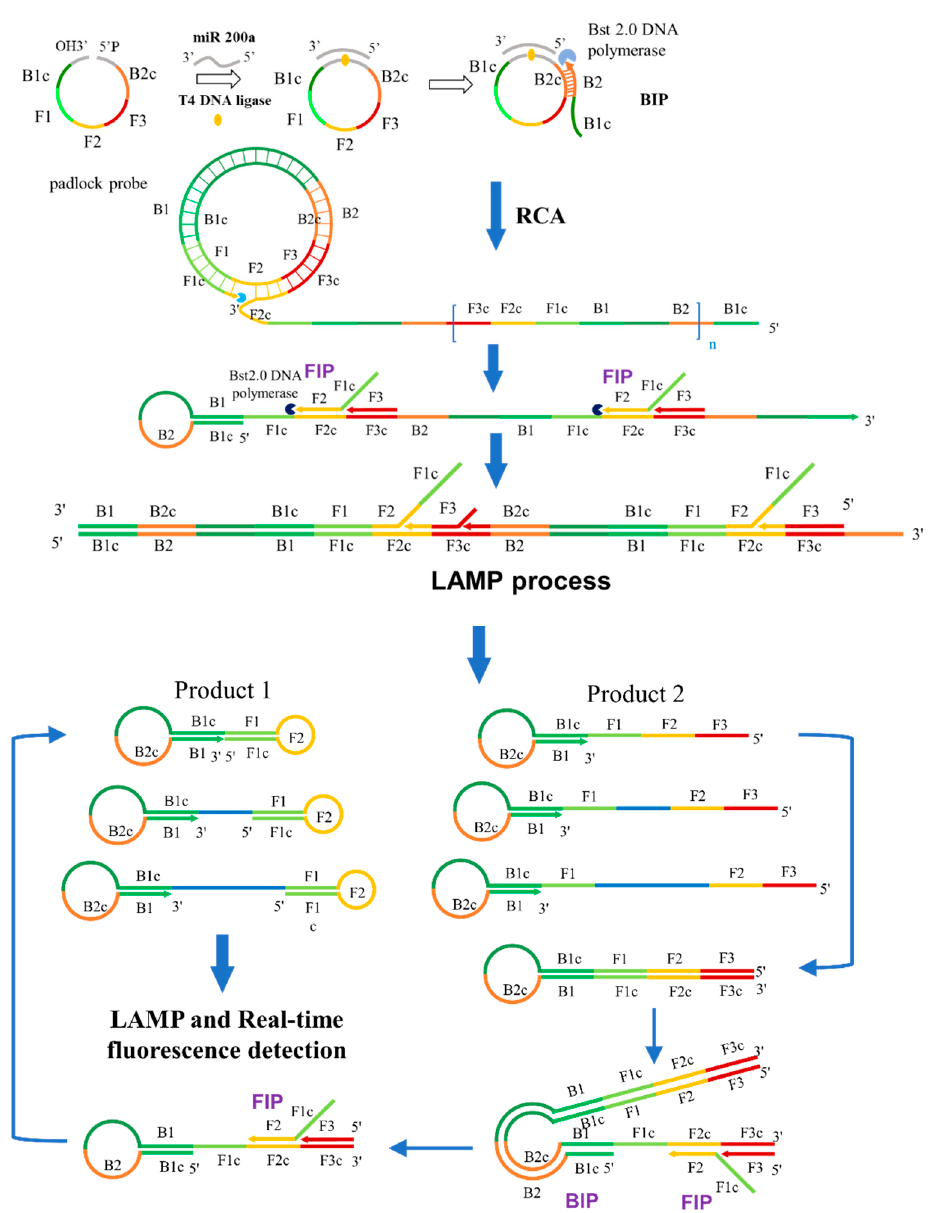
Scheme 1. Schematic representation of the RC-LAMP method for miRNA detection.